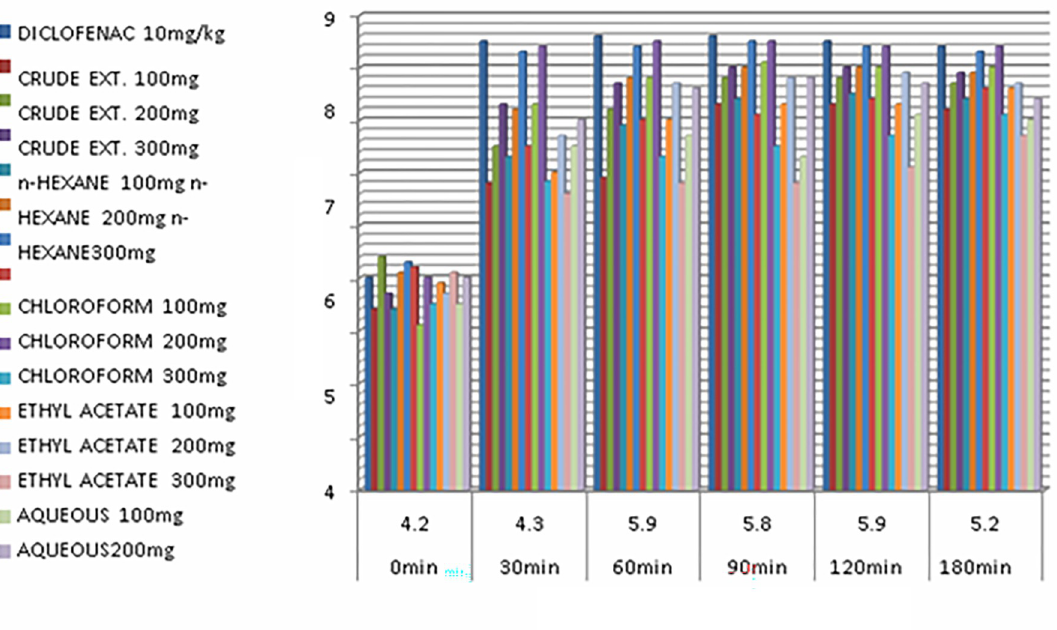
Fig 4. Analgesic activity of Iris albicans crude extract and its sub-fractions. Analgesic effect was evaluated using Hot -Plate test in animal model (n =